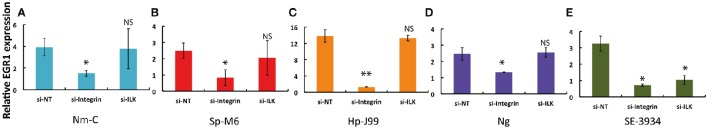
Integrin mediated signaling in bacteria induced EGR1 expression. The host epithelial cells were transfected with control siRNA (si-NT), siRNA targeted against β1-integrin (si-Integrin) or directed against integrin-linked kinase (si-ILK) for 60–68 h. The cells were then infected with bacteria with a MOI of 100 for 2 h, except the infection with N. gonorrhoeae that continued for 4 h. EGR1 expression was analyzed by qPCR. The graphs represent fold difference in EGR1 expression between infected and uninfected epithelial cells. (A) FaDu infected with N. meningitidis serogroup C (Nm-C). (B) FaDu infected with S. pyogenes serogroup M6 (Sp-M6). (C) MKN45 infected with H. pylori J99 (Hp-J99). (D) ME180 infected with N. gonorrhoea MS11 (Ng). (E) Caco-2 infected with S. Enteritidis (SE-3934).